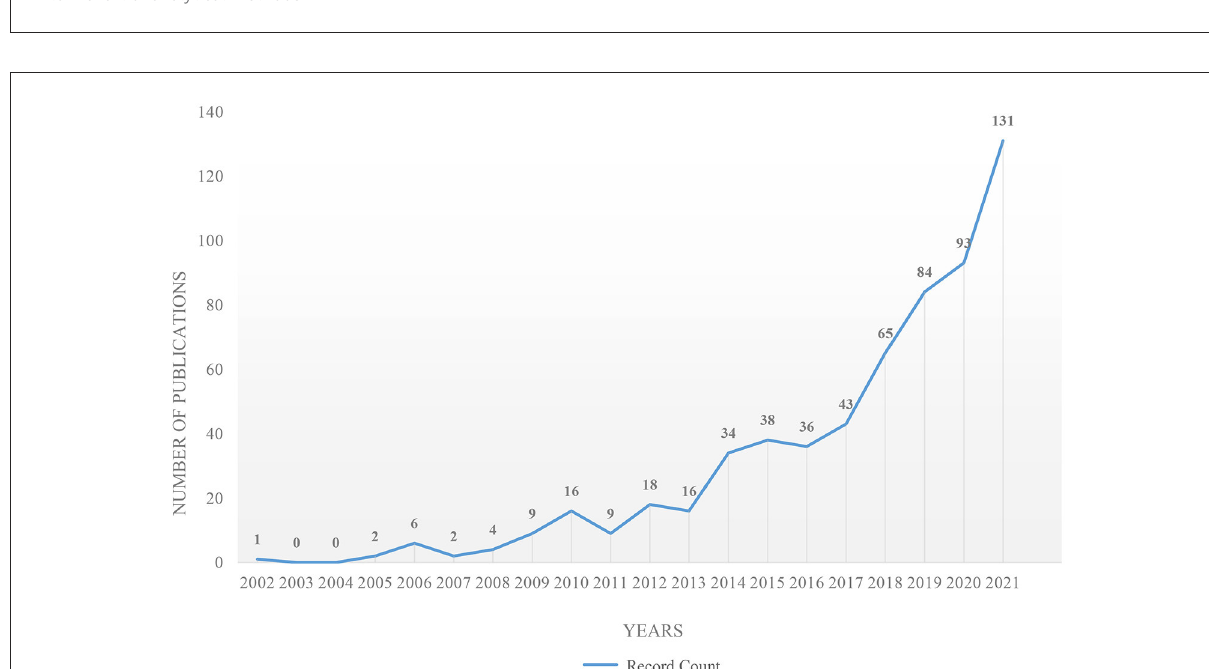
FIGURE2 Literature distribution by years concerning the study of urban green space and health behaviors. Graphical representation based on WOS Core Collection search on July 19th, 2022.